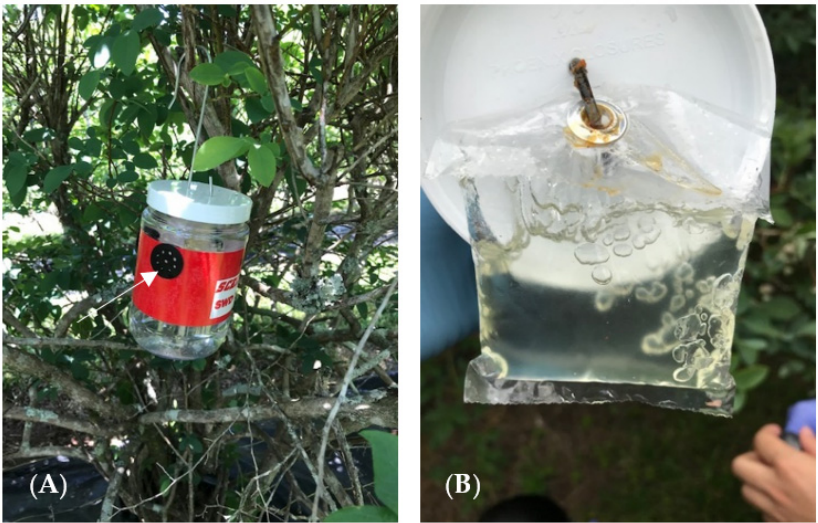
Figure 2. ( A ). Image of a Scentry ® trap with red color tape, and arrow showing holes for adult fly entrance; ( B ). Lure, used in this study. entrance; ( B ) Lure, used in this